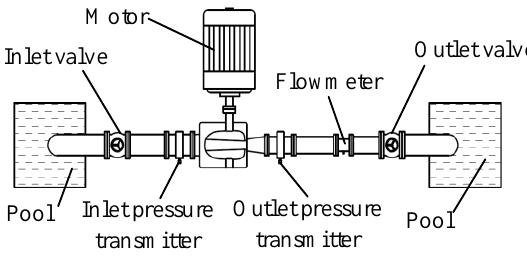
Figure 5. Test rig schematics.